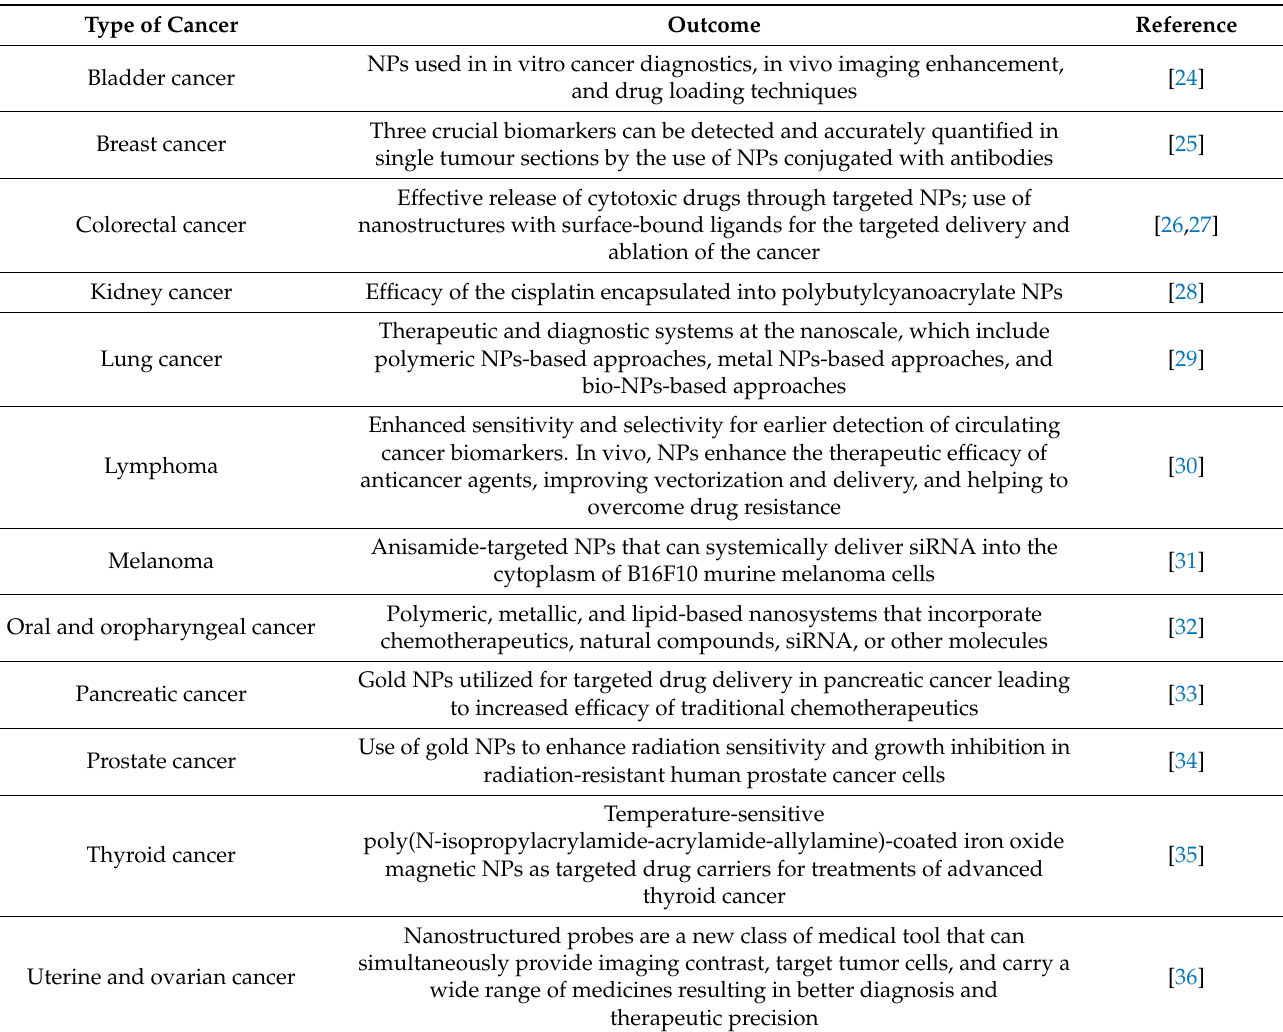
Table 1. Summary of the use of nanoparticles to treat different cancers. NPs = nanoparticles; siRNA = short-interfering